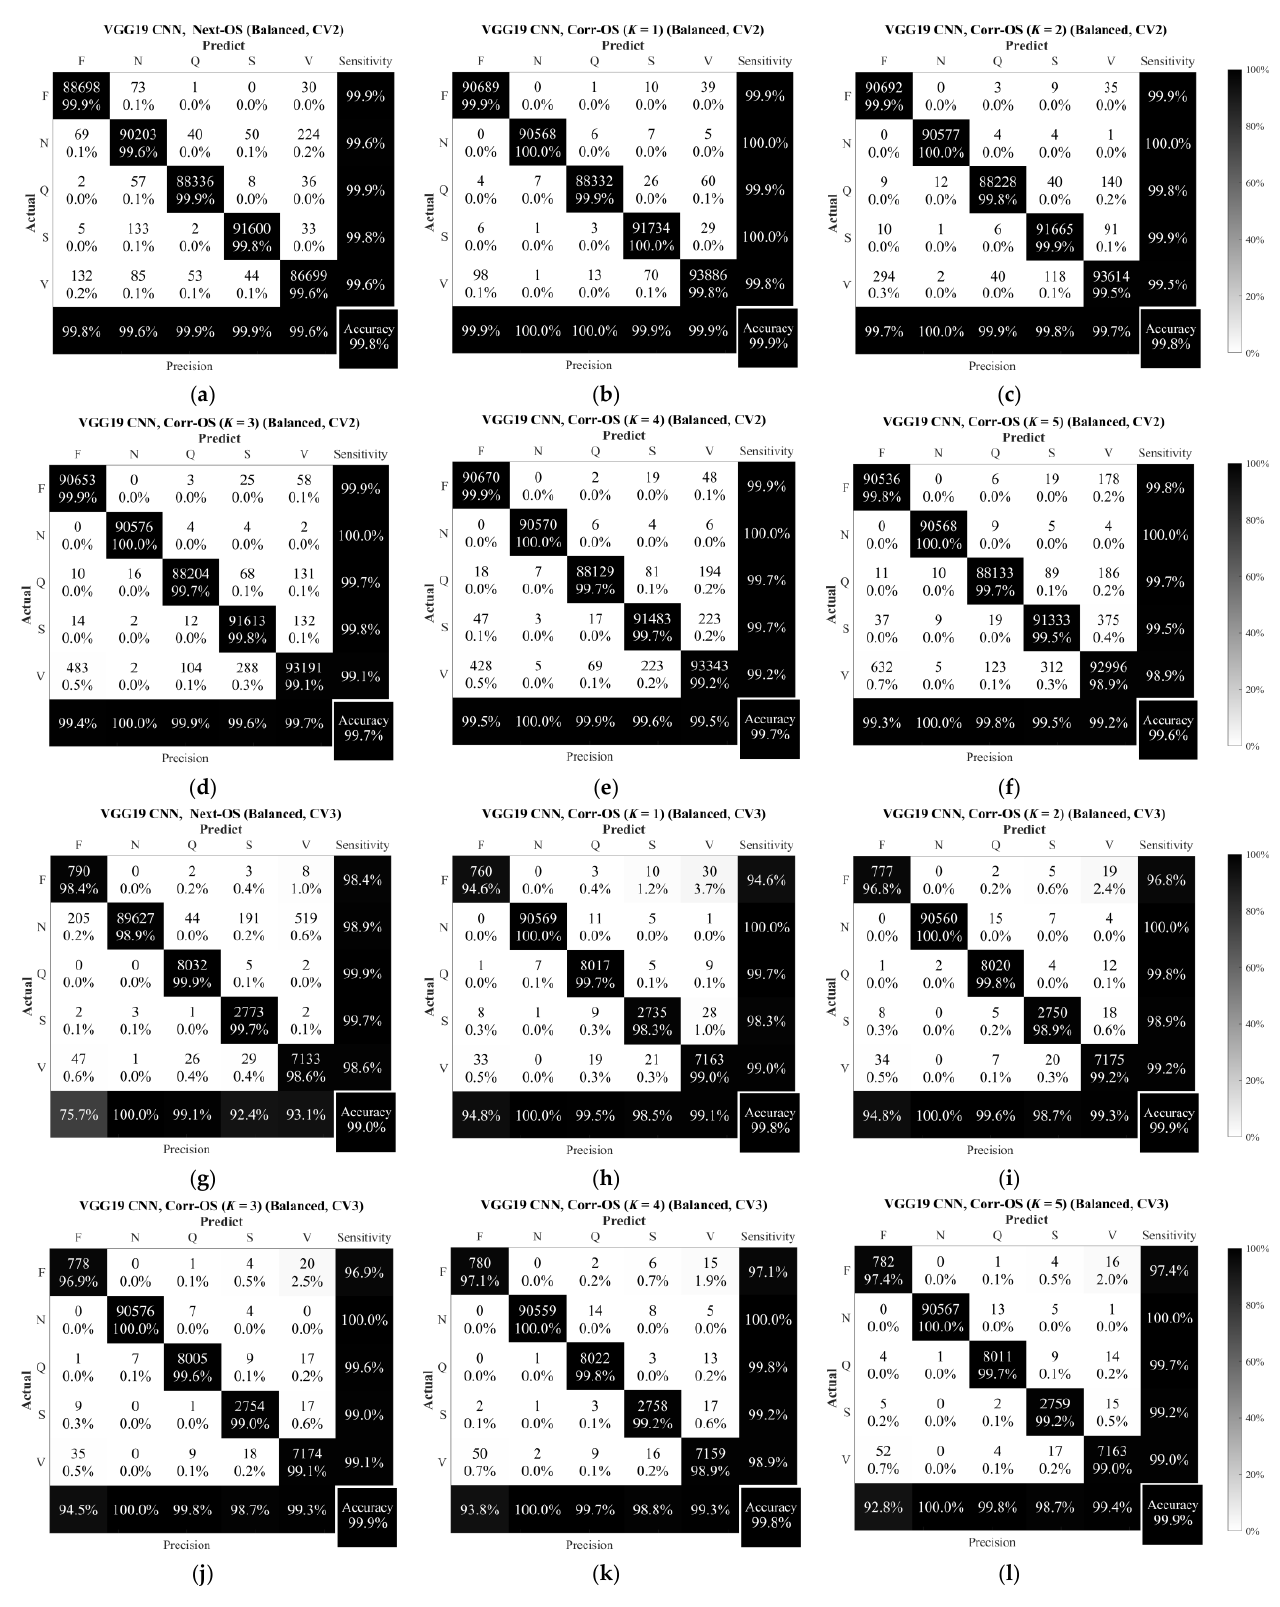
Figure A4. Confusion matrix of VGG19 using CV2 for ( a ) Next-OS, ( b ) Corr-OS ( K = 1), ( c ) Corr-OS ( K = 2), ( d ) Corr-OS ( K = 3), ( e ) Corr-OS ( K = 4), and ( f ) Corr-OS ( K = 5); using CV3 for ( g ) Next-OS, ( h ) Corr-OS ( K = 1), ( i ) Corr-OS ( K = 2), ( j ) Corr-OS ( K = 3), ( k ) Corr-OS ( K = 4), and ( l ) Corr-OS ( K = 5).